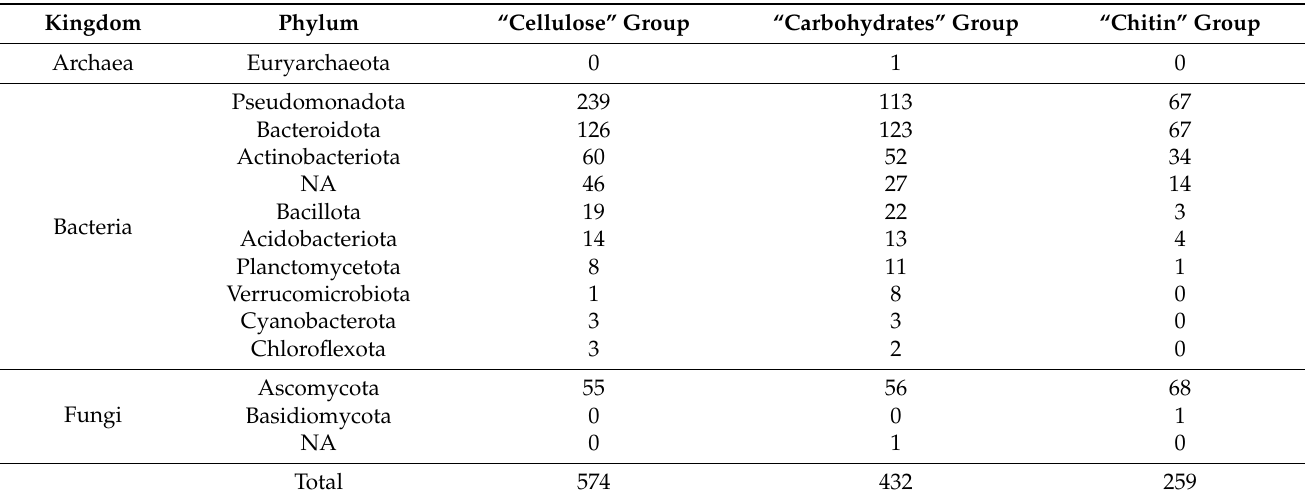
Table 1. The distribution of the main GH families found in the metagenome of the cellulolytic community between phyla. Three groups of GH families were distinguished: “cellulose” (GH3, GH5, GH9, GH43, GH94, GH30, etc.), “carbohydrates” (GH31, GH95, GH15, GH77, GH38, GH32, etc.), and “chitin” (GH18, GH19,